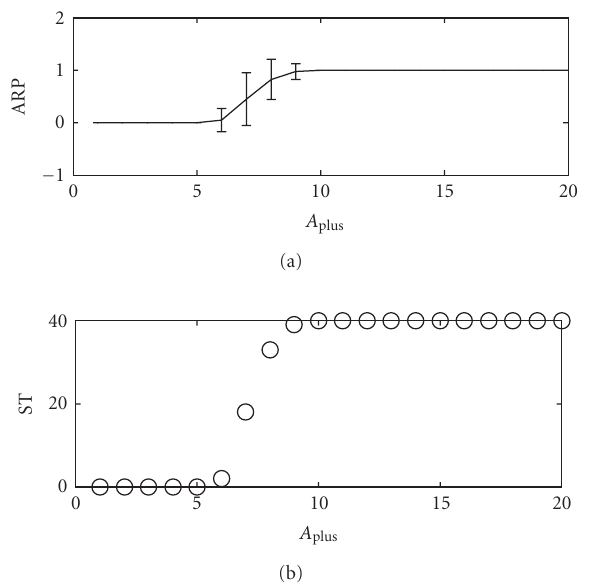
Figure 4: It shows that the regulation of A plus to synchronization for the dc-STDP carrying out 40 times of stimulations. A sub = 6 nS, t plus = 100 milliseconds, t = 200 milliseconds, T = 233 milliseconds. sub 2 Top: the value of ARP = (cid:4) T 2 − (cid:4) T 21 (cid:5)(cid:5) / ( T 2 − T 1 ) is 0 or 1 which, respectively, means post-synaptic neuron keeping initial period or achieving synchronization. Bottom: the number of synchronization times (ST) in 40 stimulations against A plus .